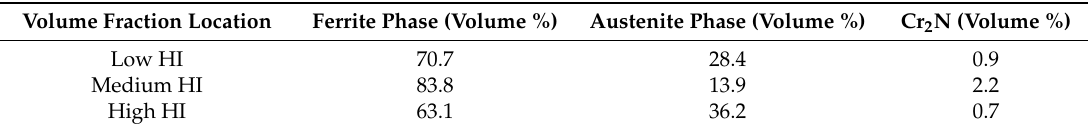
Table 4. Summary of phase fractions at the edge of the weld under several welding conditiosn from the EBSD results.